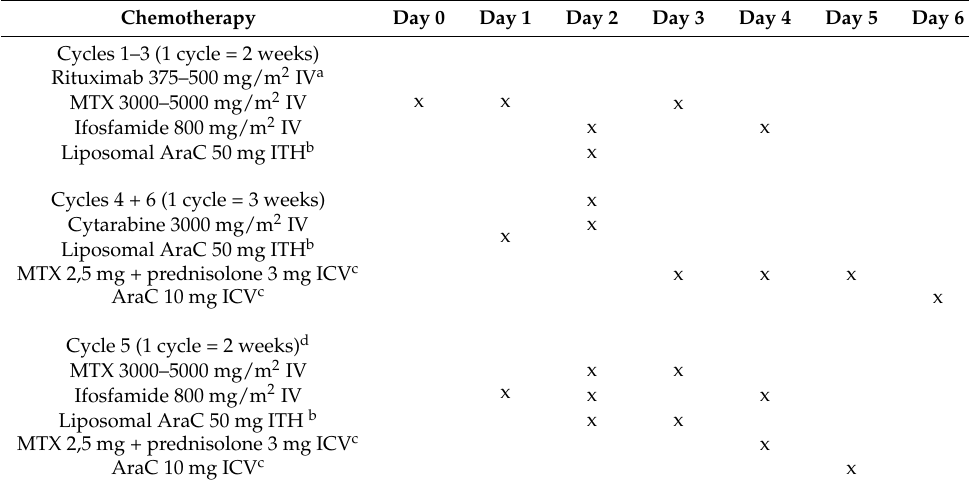
Table 1. Modified Bonn